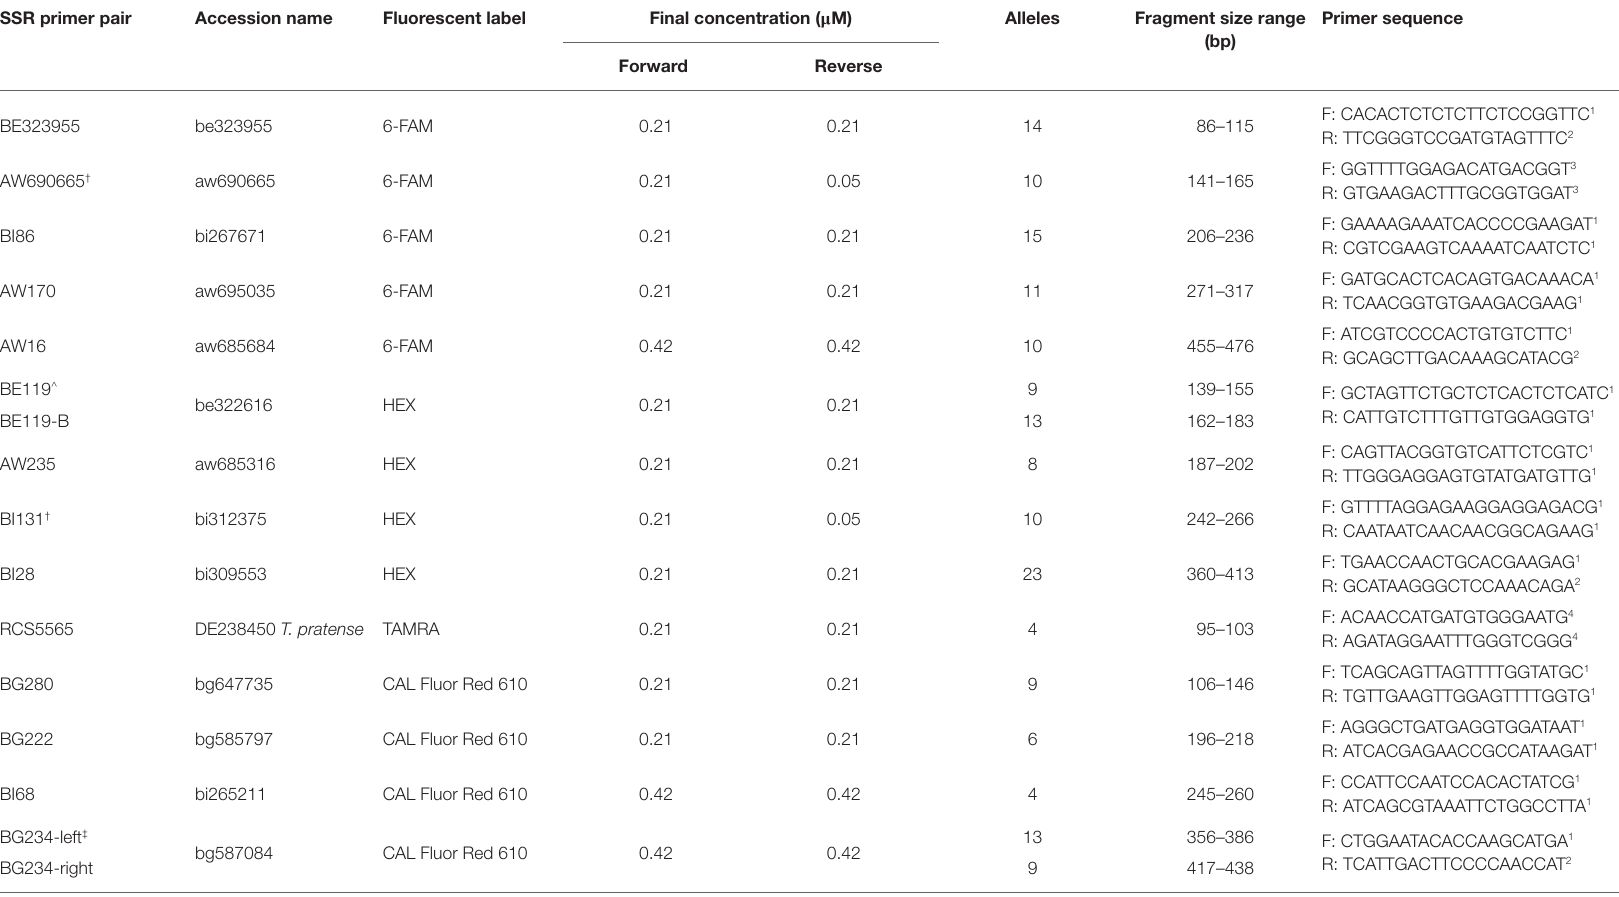
TABLE 1 | Sixteen simple sequence repeat (SSR) loci used to genotype maternal alfalfa plats and progeny. SSR primer